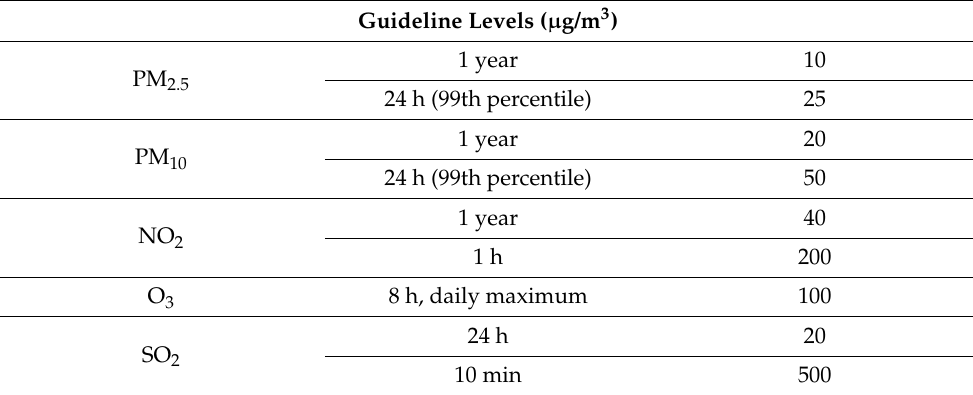
Table 1. WHO air quality